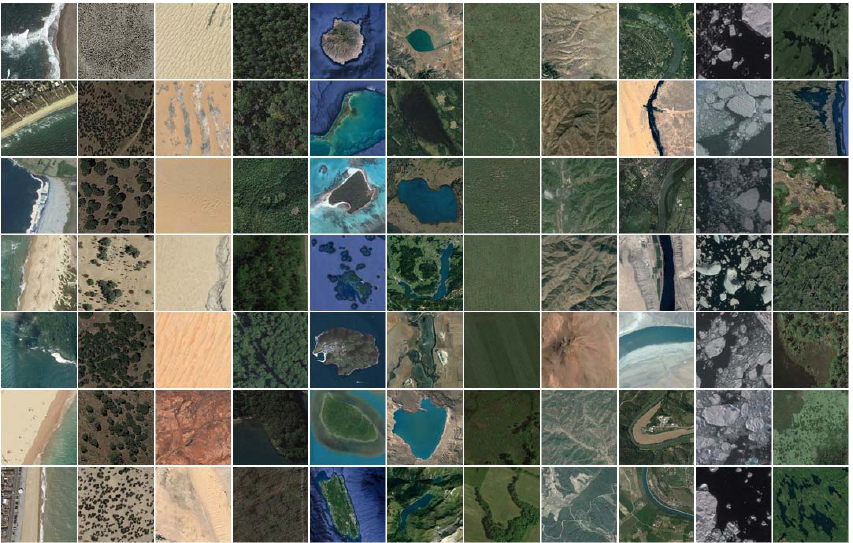
Figure 3. Example tiles from NWPU dataset. Classes, in columns, from left to right, are beach, chaparral, desert, forest, island, lake, meadow, mountain, river, sea ice, and wetland.